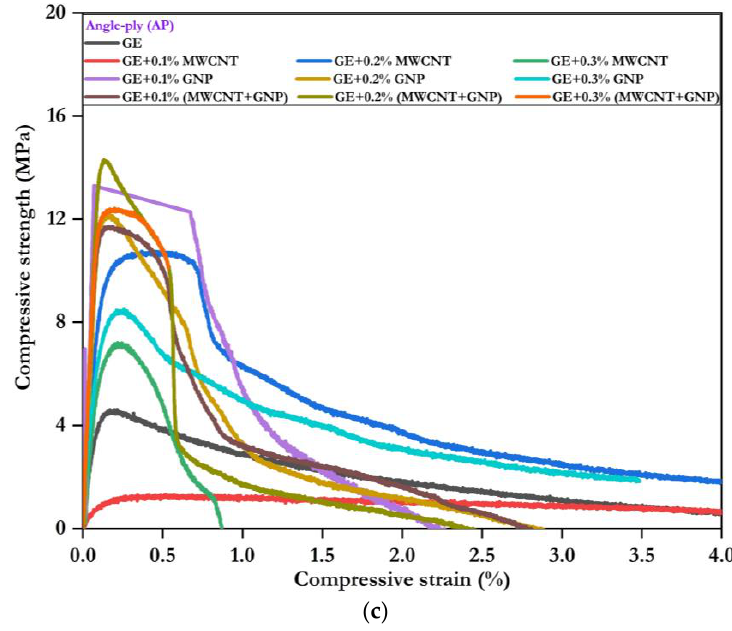
Figure 7. Compressive stress – strain response: ( a ) UD, ( b ) CP, and ( c ) AP.